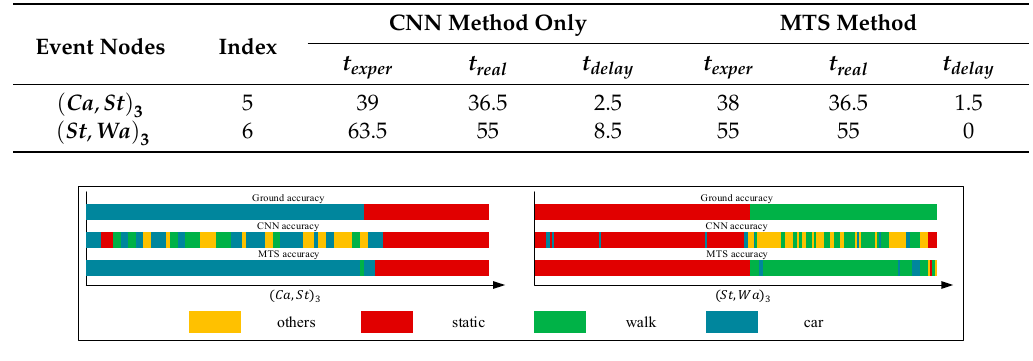
Figure 18. Graphs of < (cid:1849)(cid:1853): (cid:1829)(cid:1853) > (cid:2870) . Table 10. Basic SE of < (cid:1829)(cid:1853), (cid:1849)(cid:1853) > (cid:2871) .